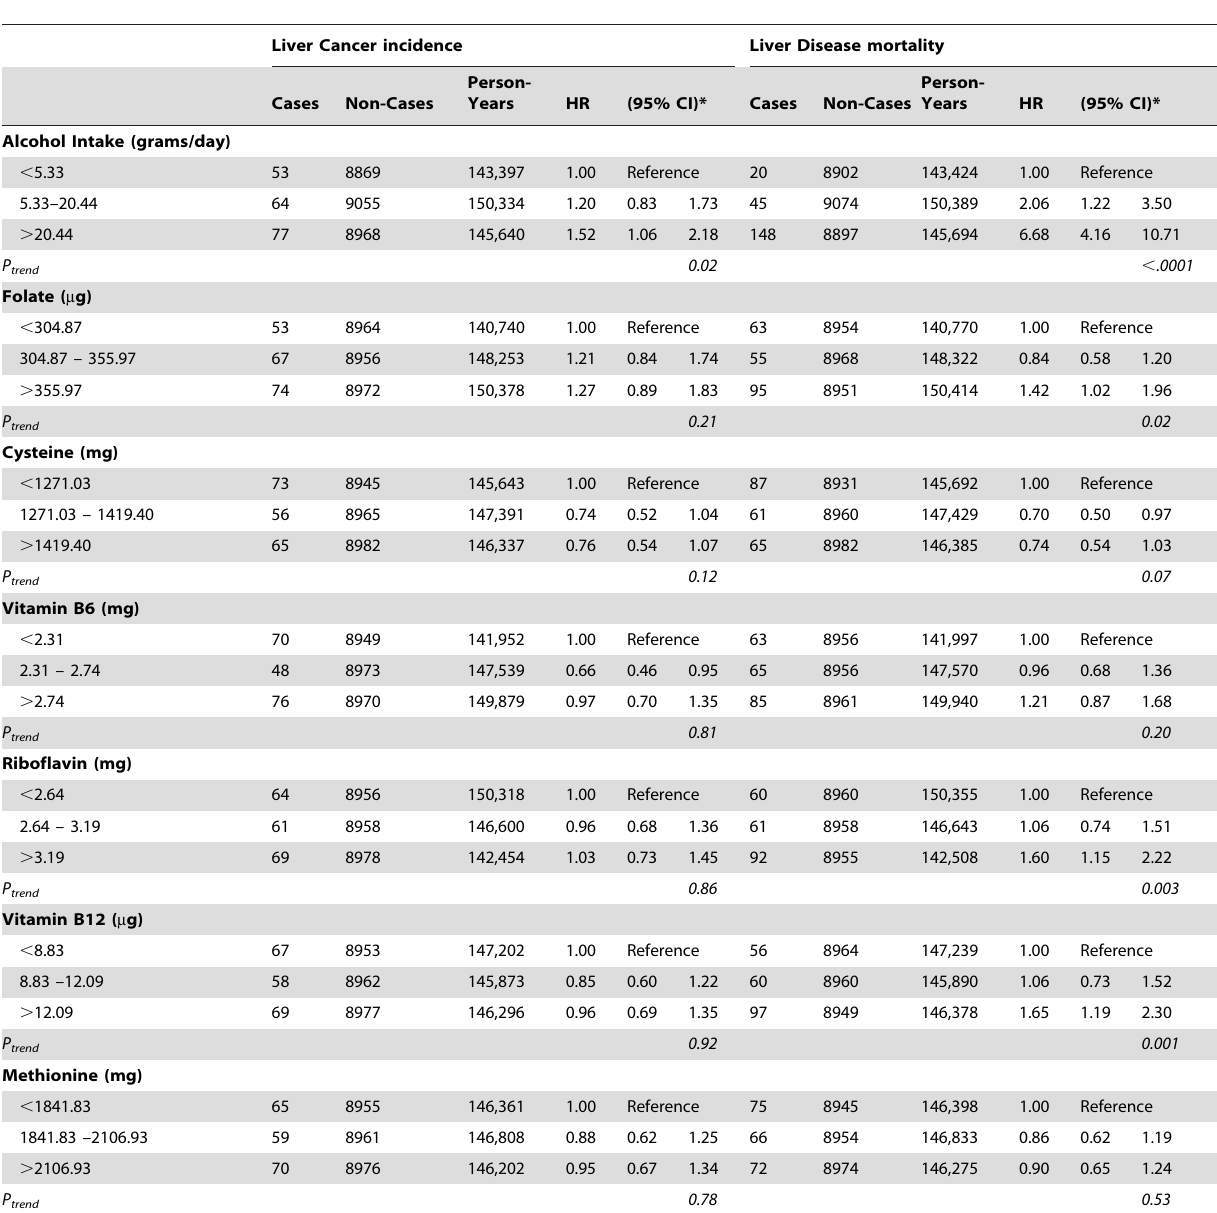
Table 2. Association between alcohol consumption and one-carbon metabolite intake and the risk of liver cancer incidence and liver disease mortality in the ATBC